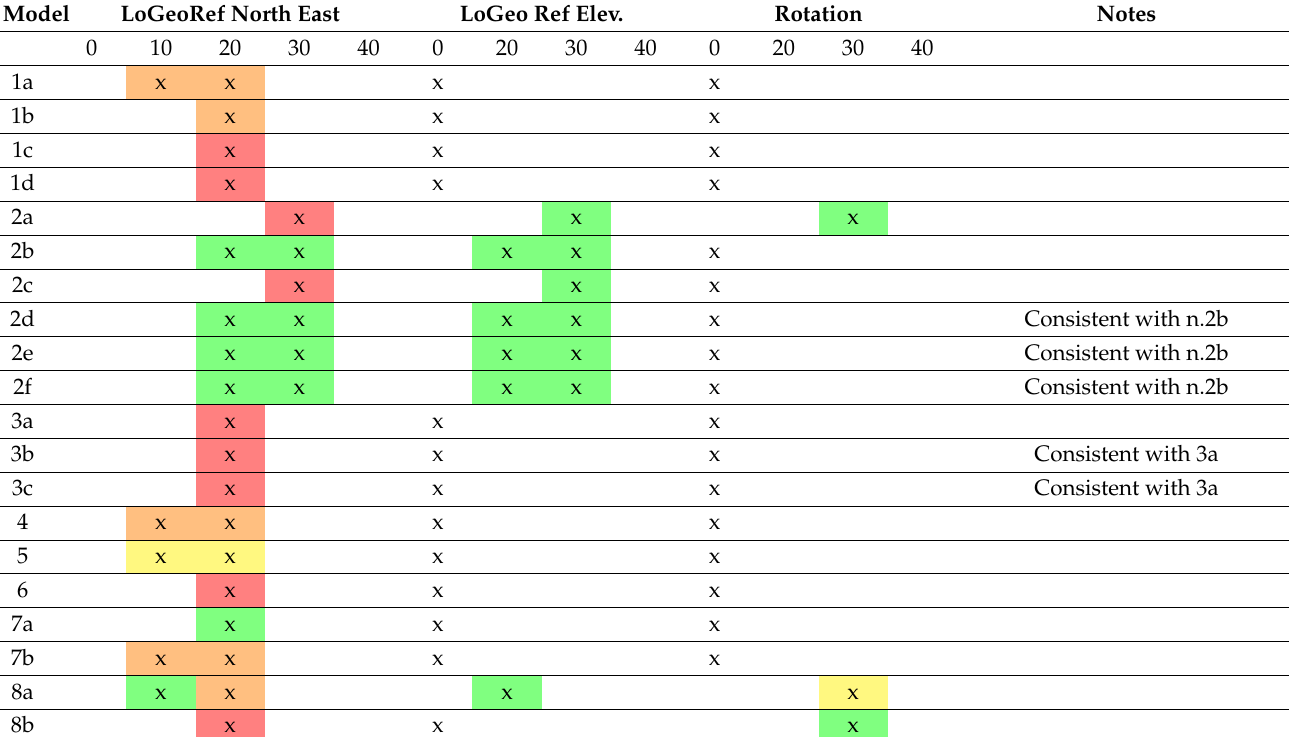
Table 3. Kind and quality of georeferencing of the inspected models. The numbers refer to the corresponding LoGeoRef (with 0 as not georeferenced or using default values) and the colours refer to the accuracy of georeferencing: red = wrong; orange = approximation as a point in the same Country than the building; yellow = approximation as a point in the same city than the building; green = accurate location of the building in its actual location. Model LoGeo Ref